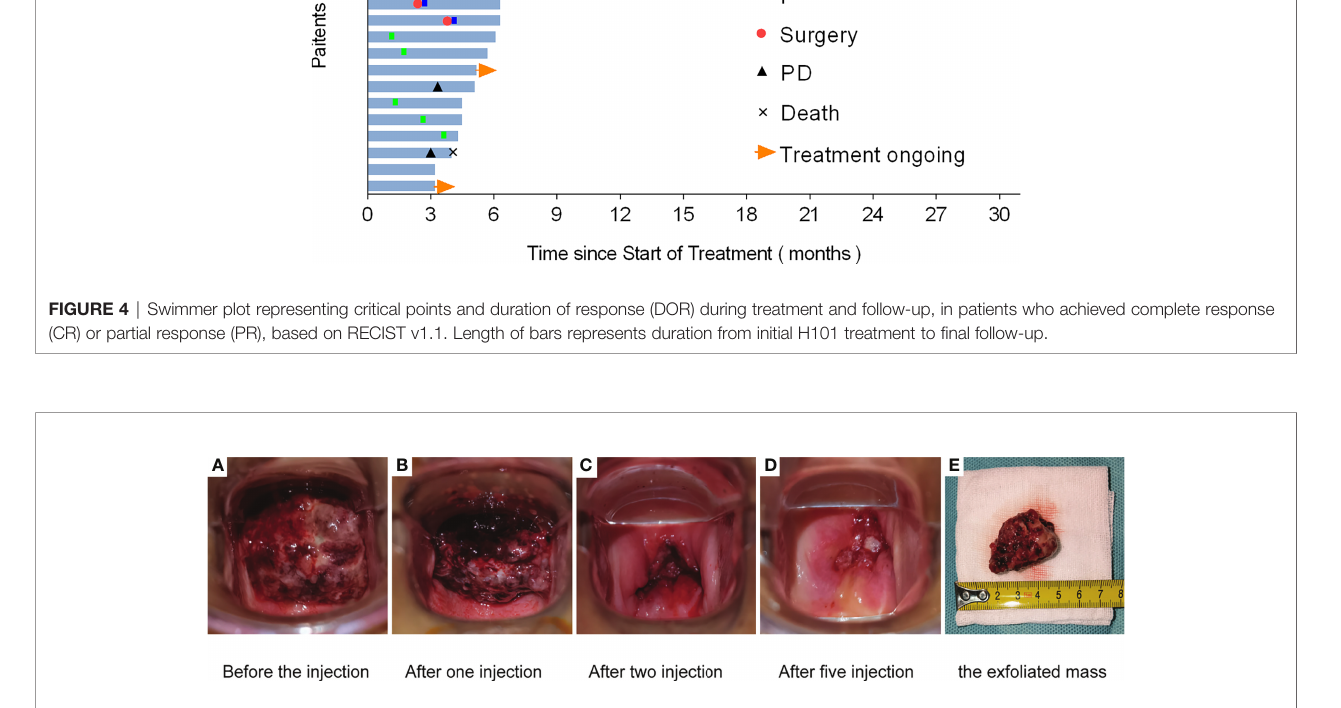
FIGURE 5 | One patient with mucinous ovarian adenocarcinoma who had received fi ve different chemotherapy regimens and 2 times of surgeries had huge metastatic carcinoma of vaginal cuff (A) . After one injection, the mass shrunk and showed necrosis (B) . The mass was partially exfoliated (E) and signi fi cantly reduced (C) after 2 injections. After completion of a course of injections (5.0 × 10 11 virus particles daily for 5 days), vaginal cuff was only minimal residual (D) .